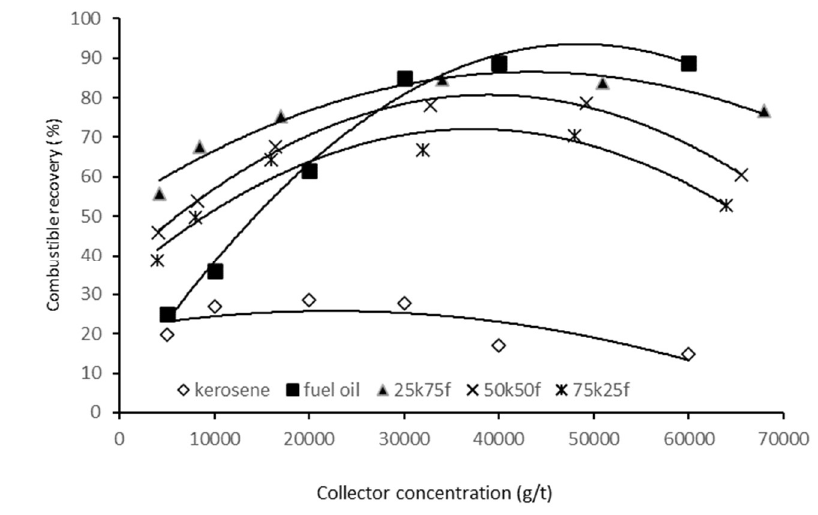
Fig.8. Effect of the concentration of kerosene and fuel oil mixtures on combustible recovery.